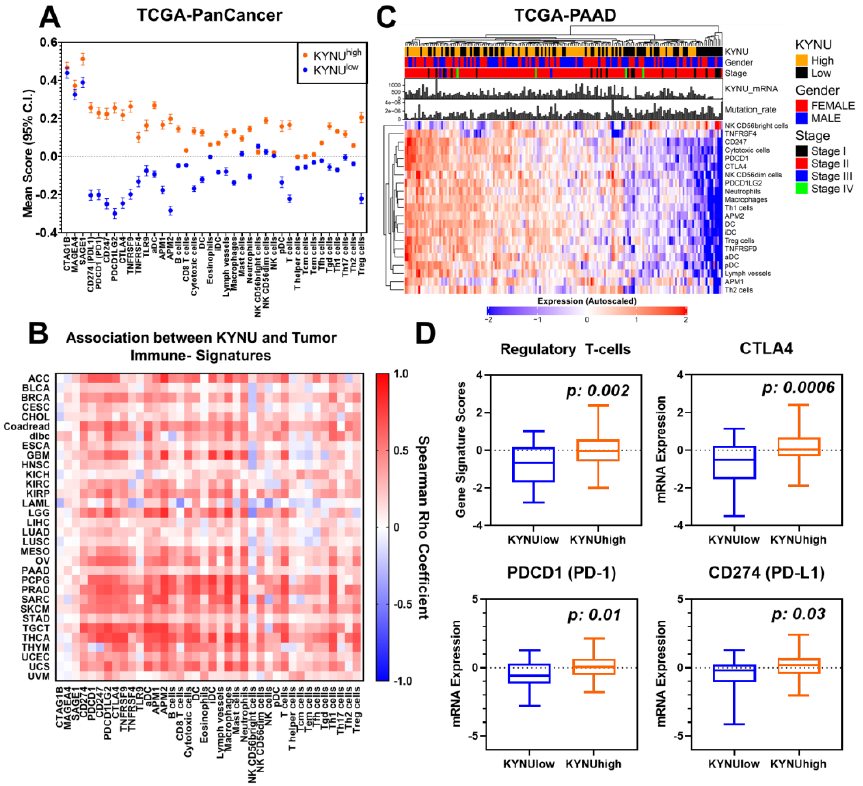
Figure 3. Association between tumoral KYNU mRNA expression and tumor